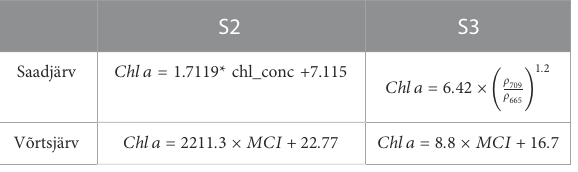
TABLE 2 Selected algorithms for Sentinel-2 MSI and Sentinel-3 OLCI data over study lakes. S2 S3 Saadjärv Chla = 1.7119* chl_conc